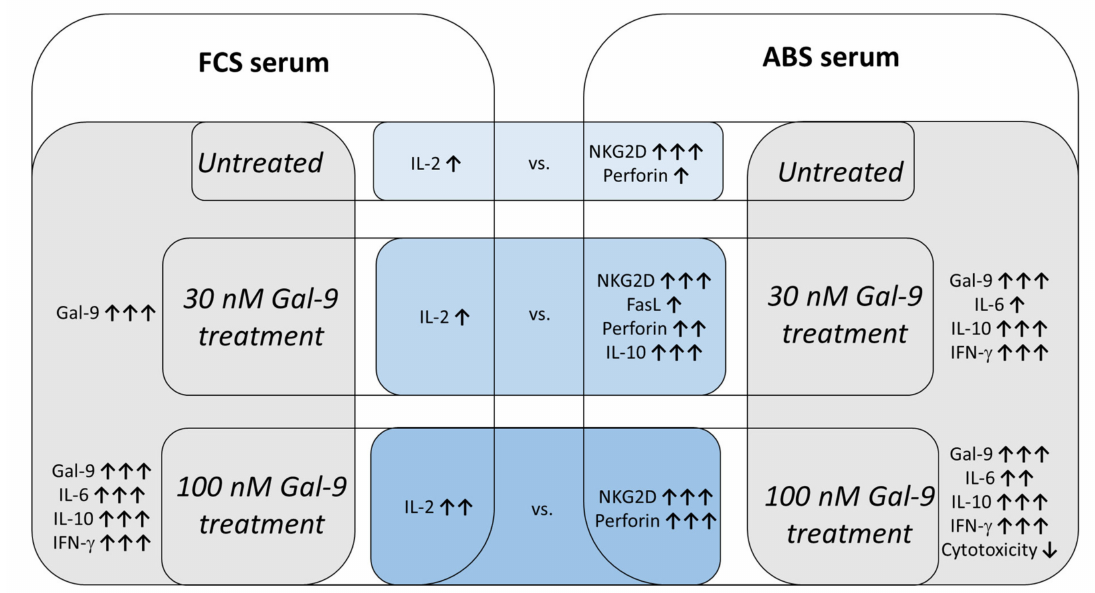
Figure 6. Comparing the effects of the two different serum supplements following recombinant Galectin-9 treatment. Upwards pointing arrows indicate an increase in a numerical value, and downwards pointing arrows indicate a